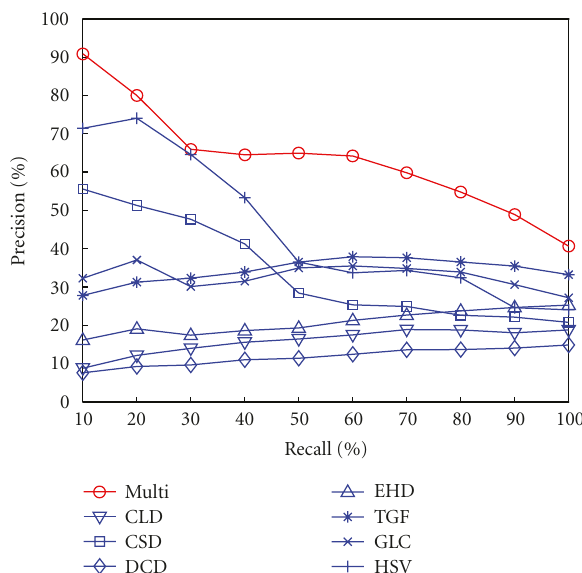
Figure 12: Precision-recall curves for concept tiger using the mul- tifeature combination metric and using single descriptors.